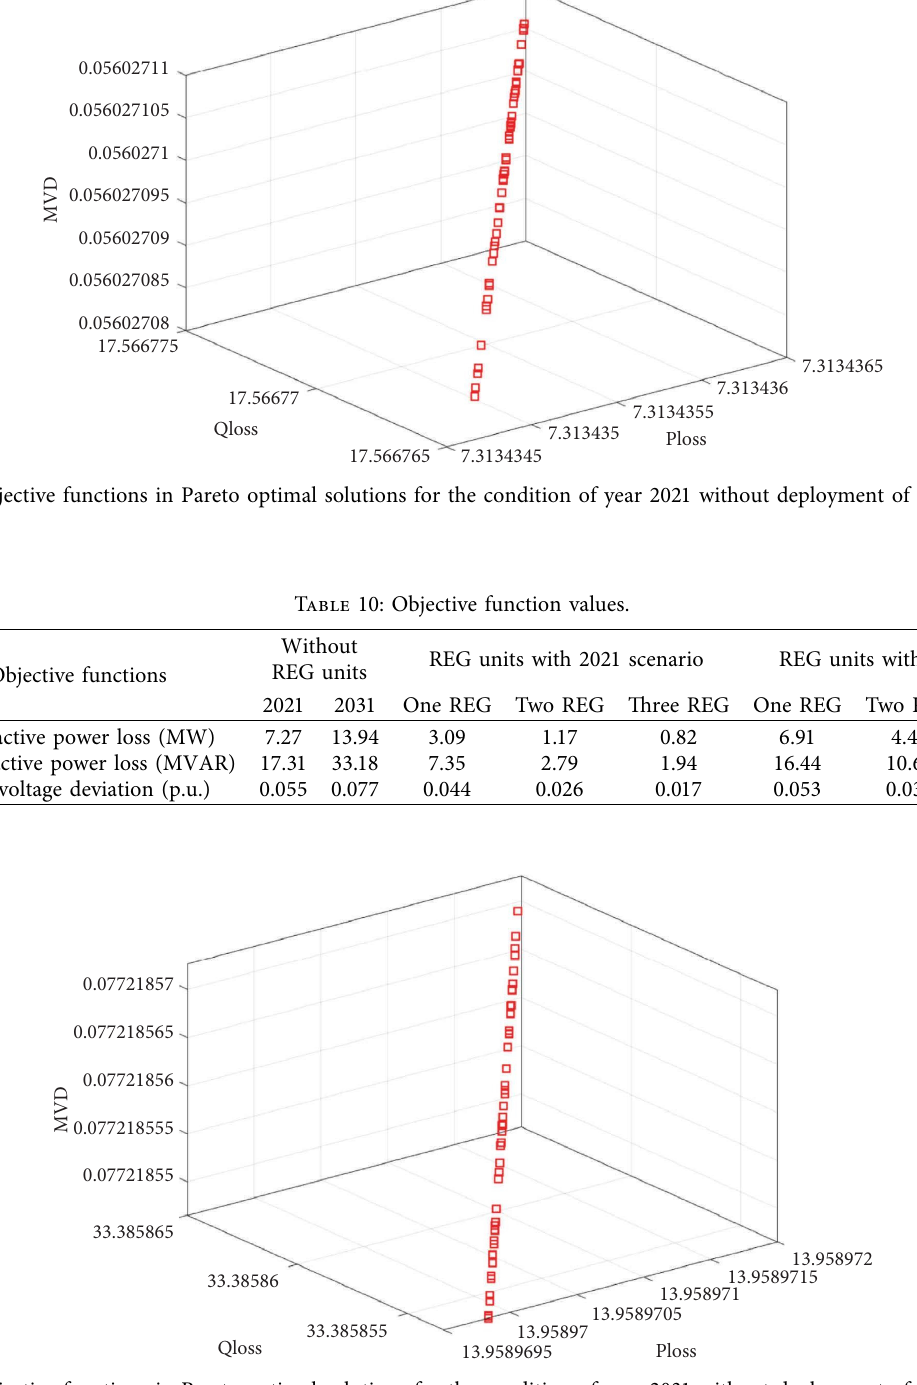
Table 11. Electricity saving (ES) in terms of kWh/year is